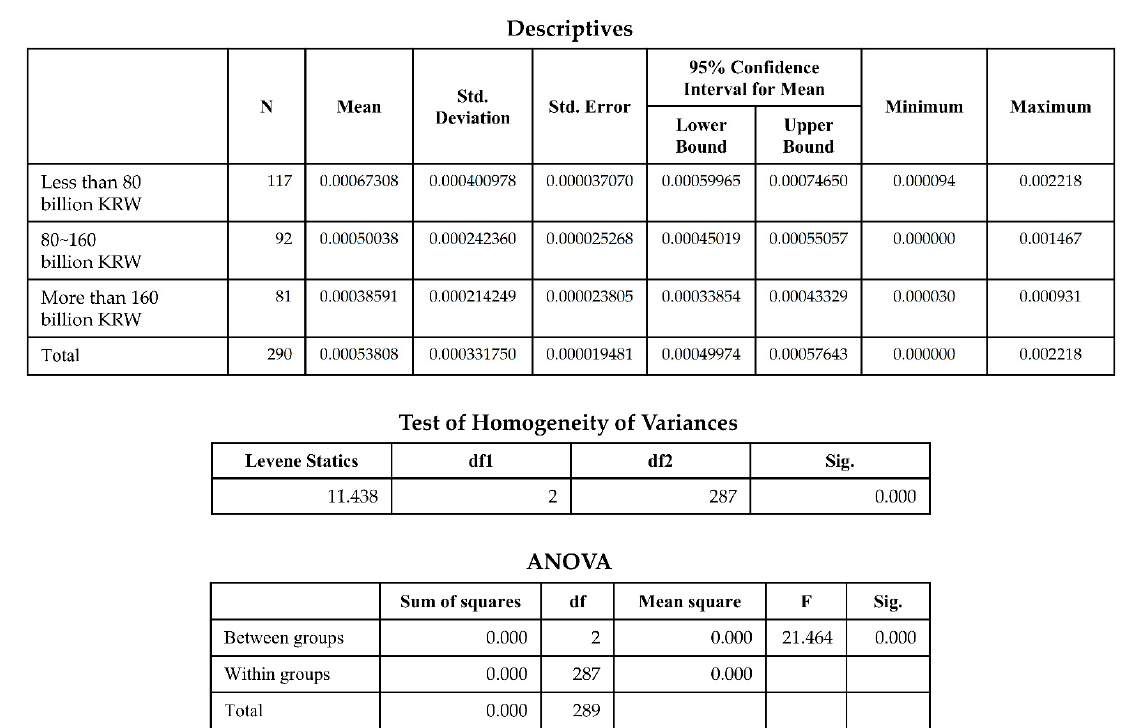
Figure A1. ANOVA result of each group to construction cost scale.